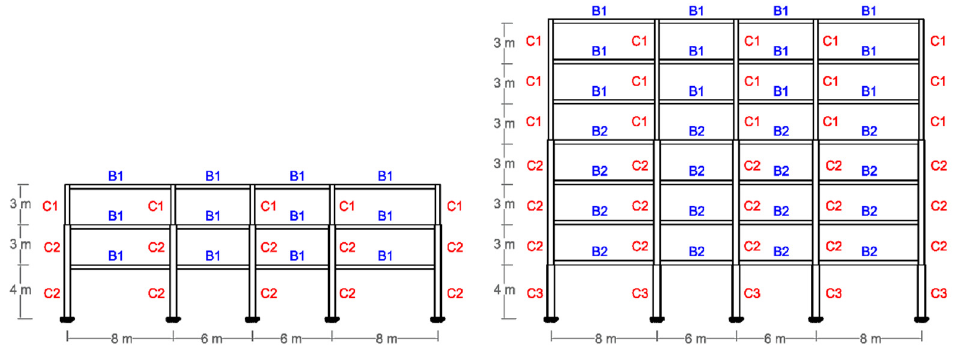
Figure 1. A 2-D view of the main frame evaluated of each building. Table 4. The main characteristics of the modal analysis of the 3- and 7-story buildings. City